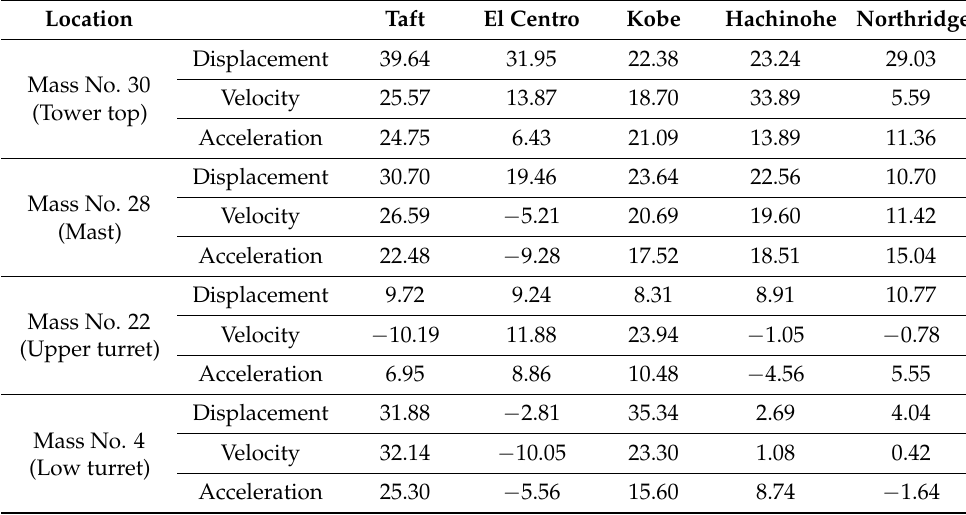
Table 4. VRFs of the TV transmission tower under different earthquakes (%).